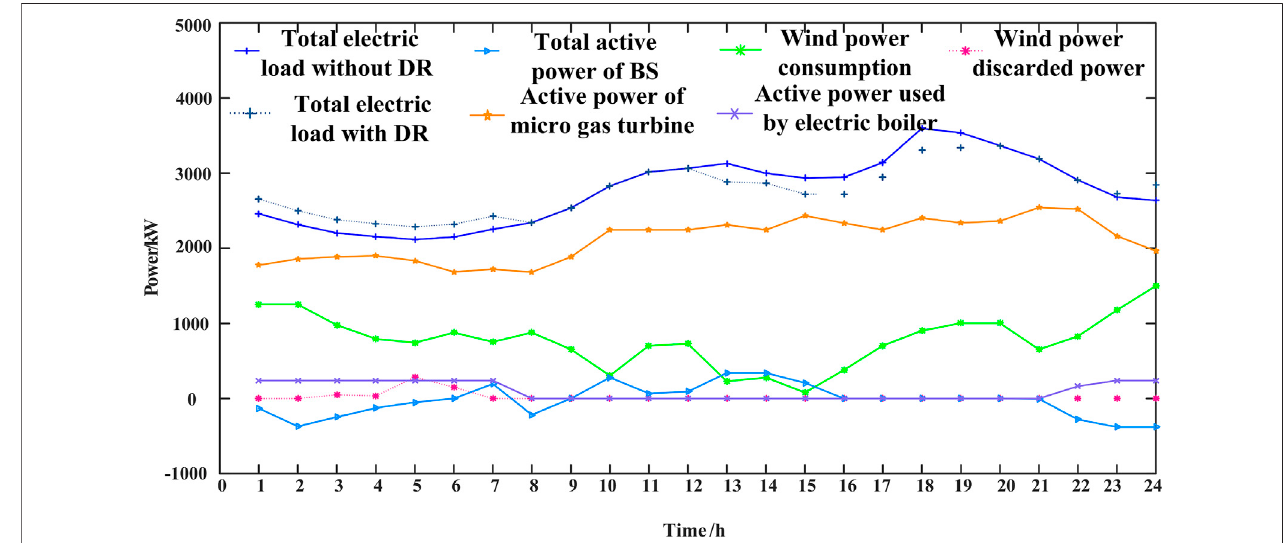
FIGURE 9 | Planned values of active power items during the day to be dispatched.